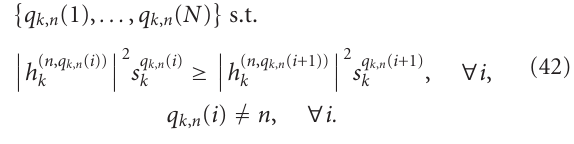
Algorithm 1: Line selection